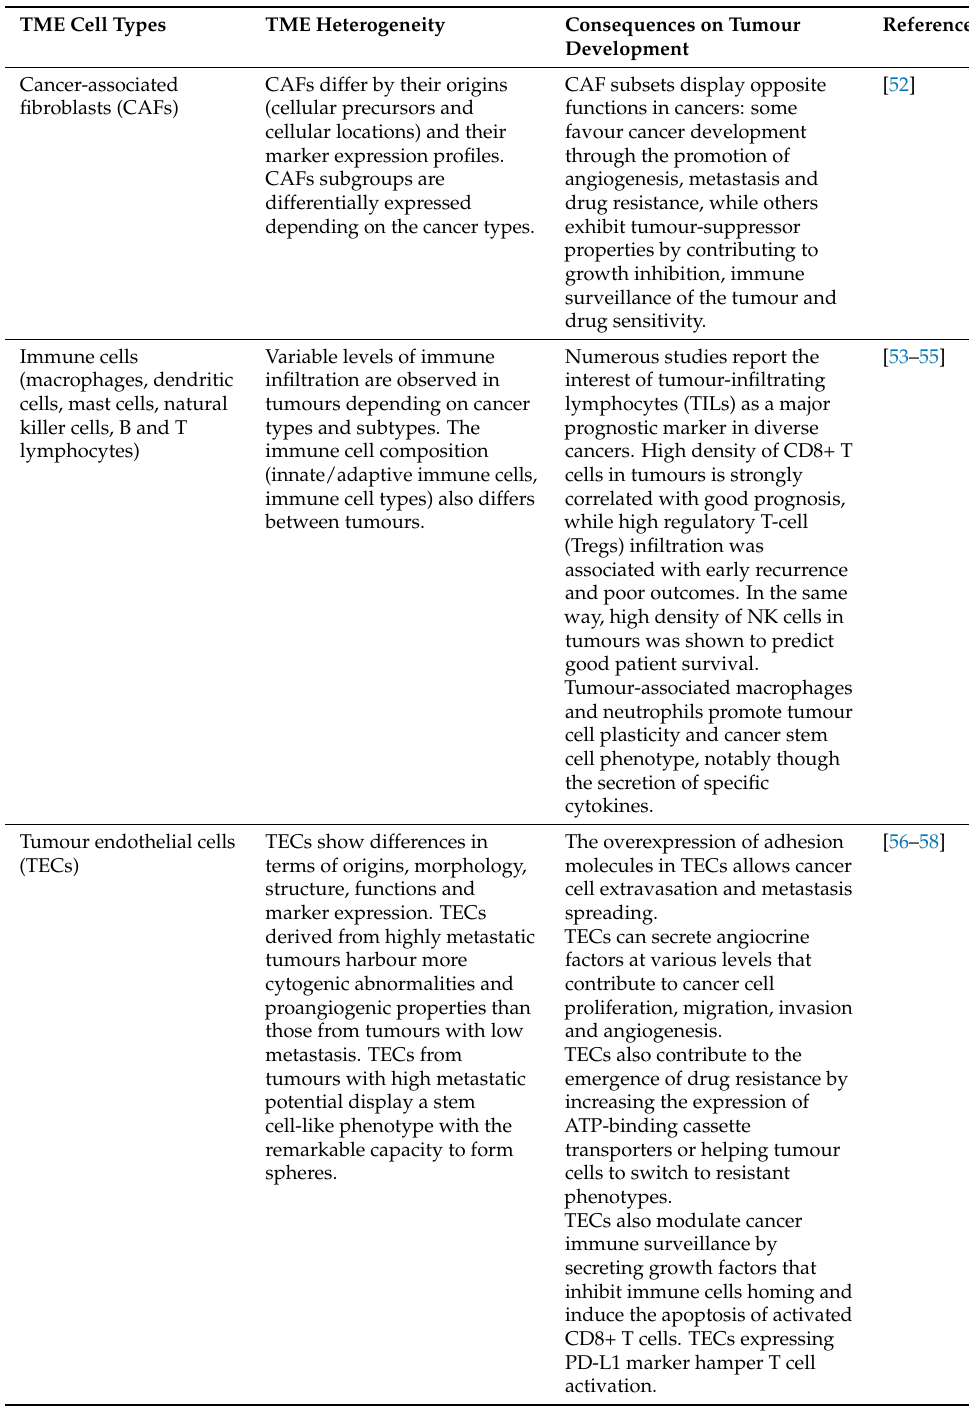
Table 1. Examples of tumour microenvironment (TME) heterogeneity and their consequences on cancer